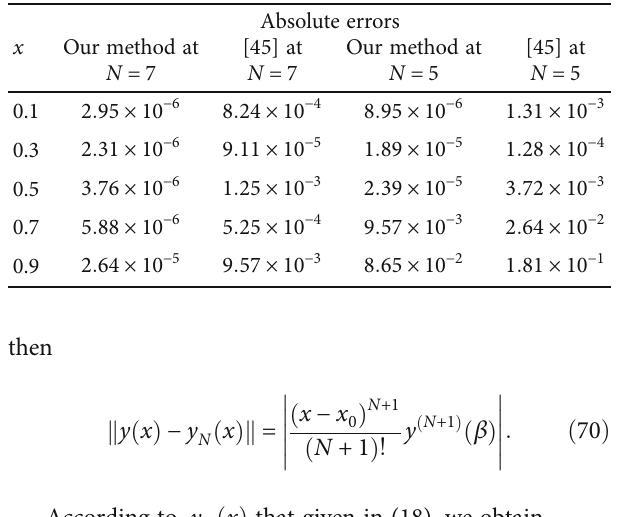
Table 5: Comparison of the absolute error of the method given in [45] and the presented method for Example 4 with di ff erent values of N , h = 1 , and τ 0 = 0